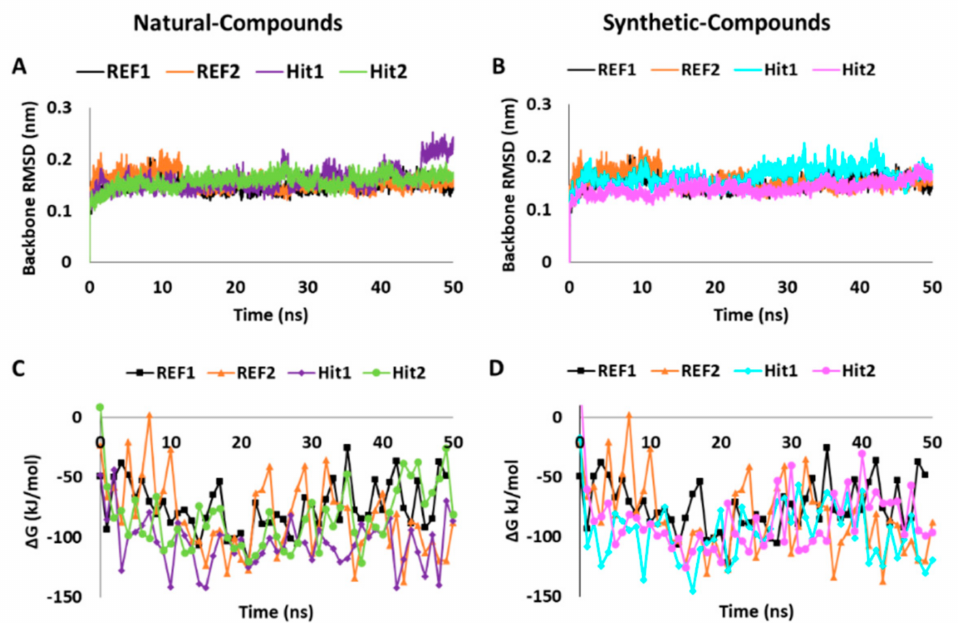
Figure 4. Molecular dynamics simulation analysis plots of Heparanase with the reference (REF) and Hits displaying ( A , B ) the backbone root mean square deviation (RMSD) and ( C , D ) the binding free energy ( ∆ G bind ) values. The left ( A , C ) and right ( B , D ) columns represent the analysis for natural and synthetic compound hits,